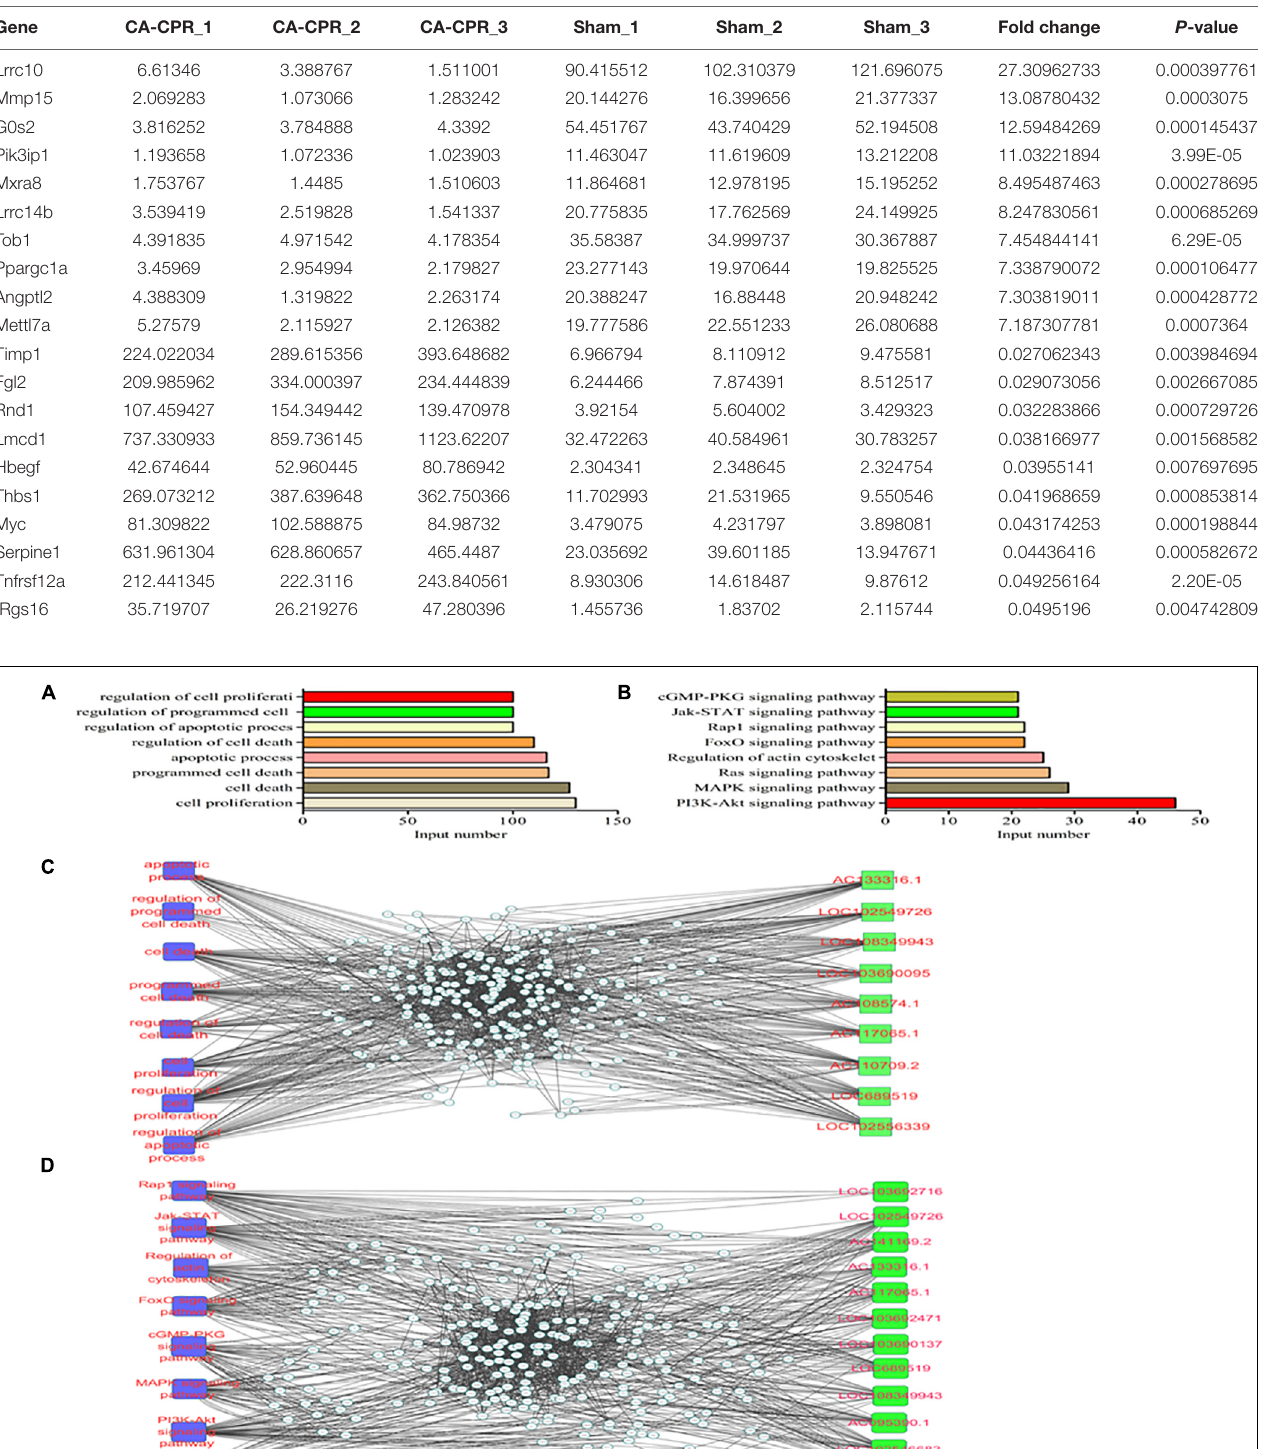
TABLE 4 | The top 20 differentially expressed mRNAs detected by high-throughput sequencing analysis.